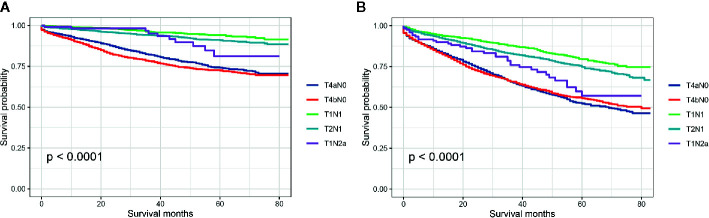

(A) Colon cancer-specific survival and (B) overall survival for stage T4aN0, stage T4bN0, stage T1N1, stage T2N1, and stage T1Na colon cancer patients.